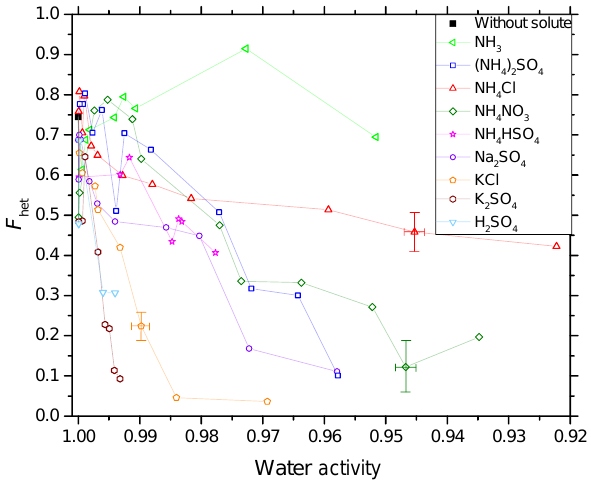
Figure 5. F het (volume fraction of water frozen heterogeneously, see Fig. 1) as function of solution water activity ( a w ). All suspen- sions contain 2wt% microcline. Three symbols carry error bars showing representative experimental variations (min to max) in F het and a w . Absolute uncertainties in F het do not exceed ±